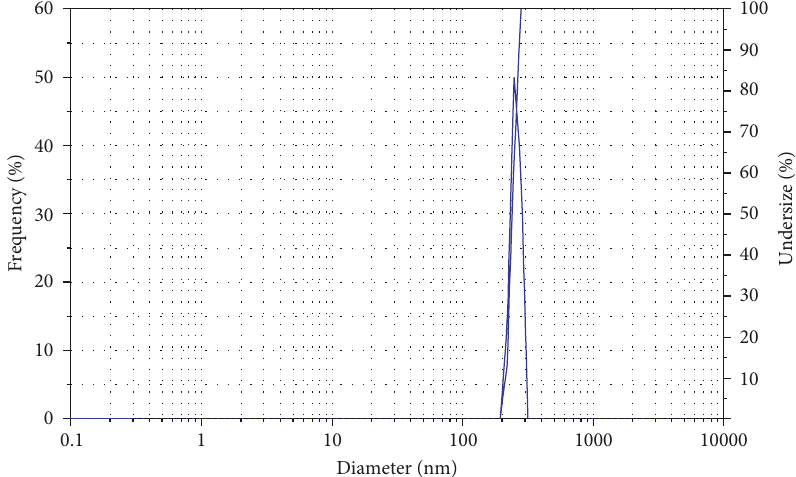
Figure 4: This picture shows the particles’ size and distribution that 63% of NPs were 240